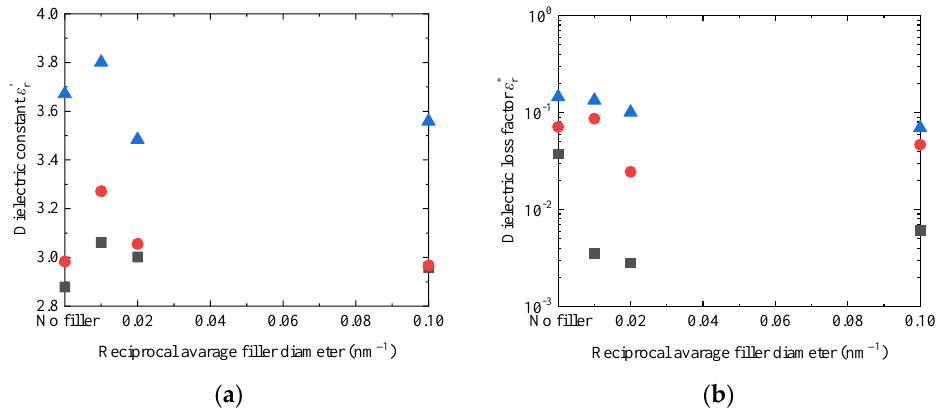
Figure 5. ε r ’ ( a ) and ε r ” ( b ) as a function of reciprocal filler diameter, measured in the epoxy resin sample and the NC samples with the filler content of 10 vol% at 20 ( ■ ), 100 (●), and 140 ( ▲ ) °C. Several data overlap each other.